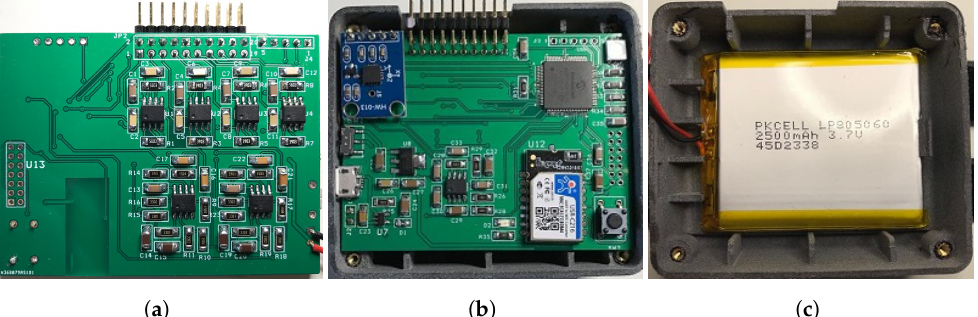
Figure 3. The Smart Chair sensors system circuit, battery, and enclosure: ( a ) circuit top layer including the analog front-end circuits; ( b ) circuit bottom layer (PCB inserted into the enclosure) including the power supply, DSP, Wi-Fi module circuits; ( c ) the enclosure hosting the